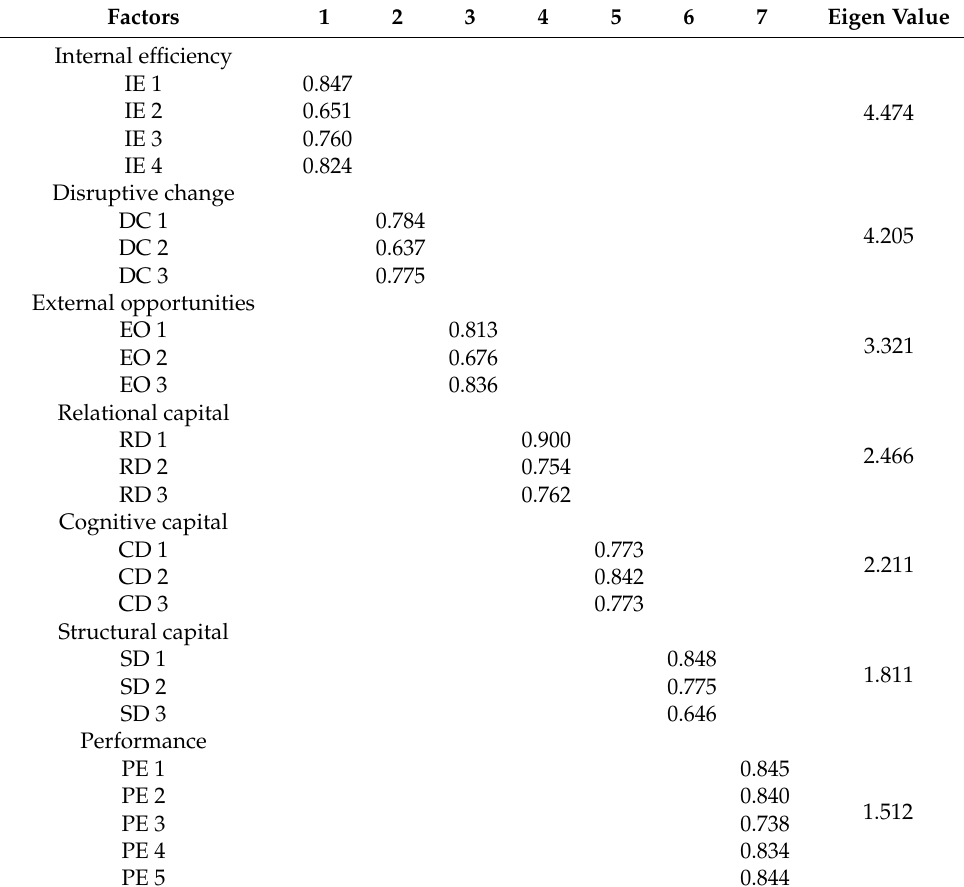
Table 3. Factor analysis for independent, mediated and dependent